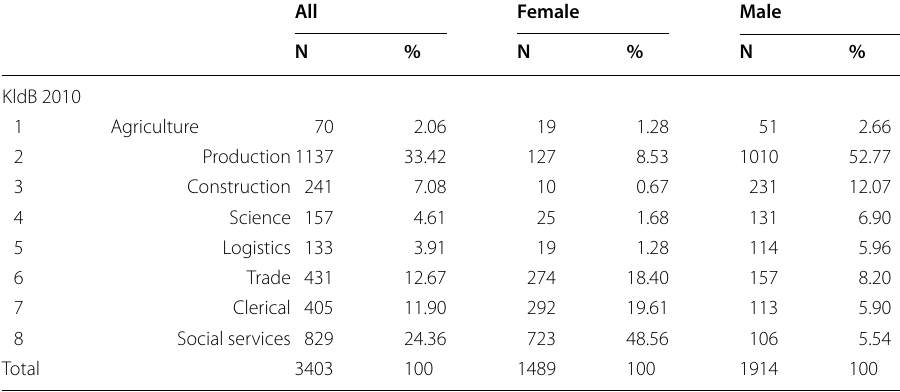
Table 3 Descriptive statistics of the dependent variable